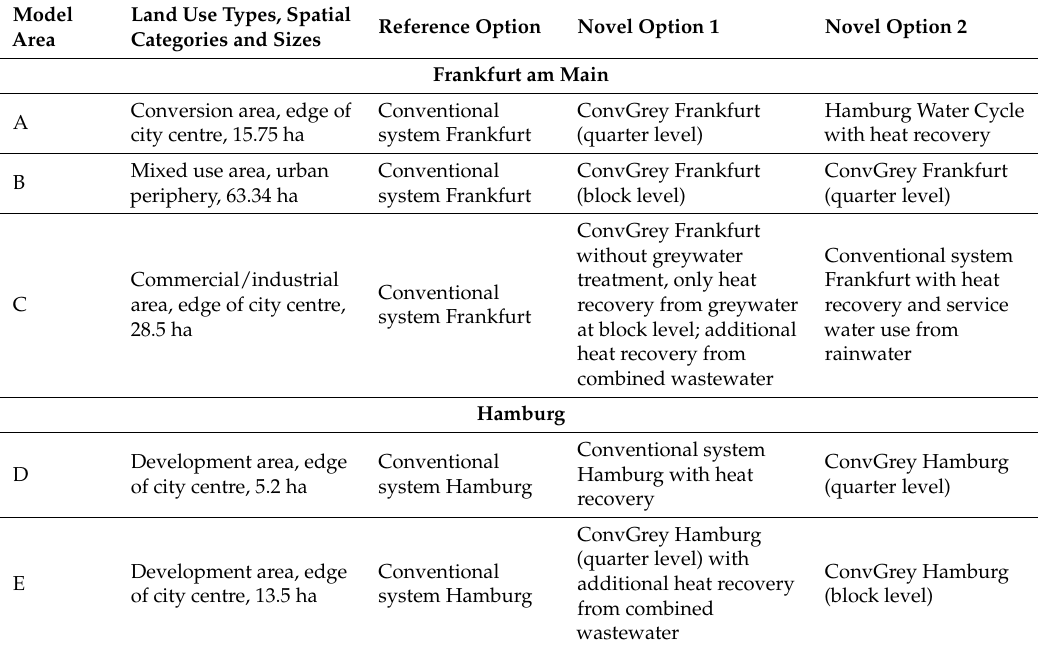
Table 1. Technical water infrastructure options for model areas (based on